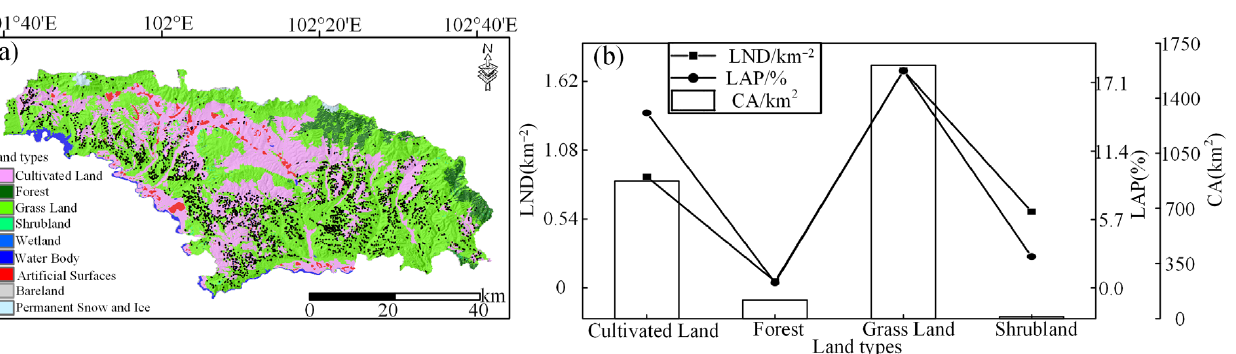
Figure 13. Relationship between land use type and landslide distribution. ( a ) Land use type distribution in the study area. ( b ) Statistics of landslide indicators in the land use type intervals.